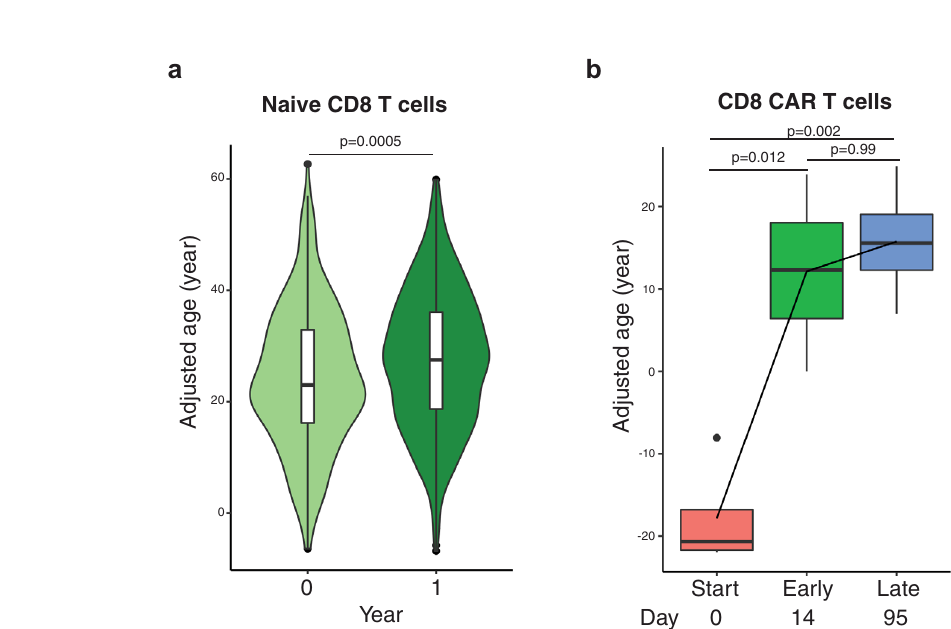
Fig. 6 | Age-relatedtranscriptomicchangesassociated with celldifferentiation anddivisions.a Linearregressionlinesrepresentingthecrossvalidationpredicted age for each of four major CD8 + T cell subsets by chronological age of donor. b Linear regression representing the relationship between mutation burden and